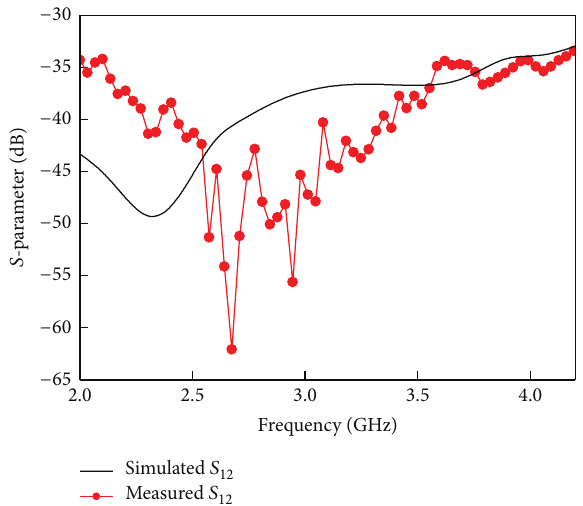
Figure 7: Measured and simulated S21 of the proposed antenna.